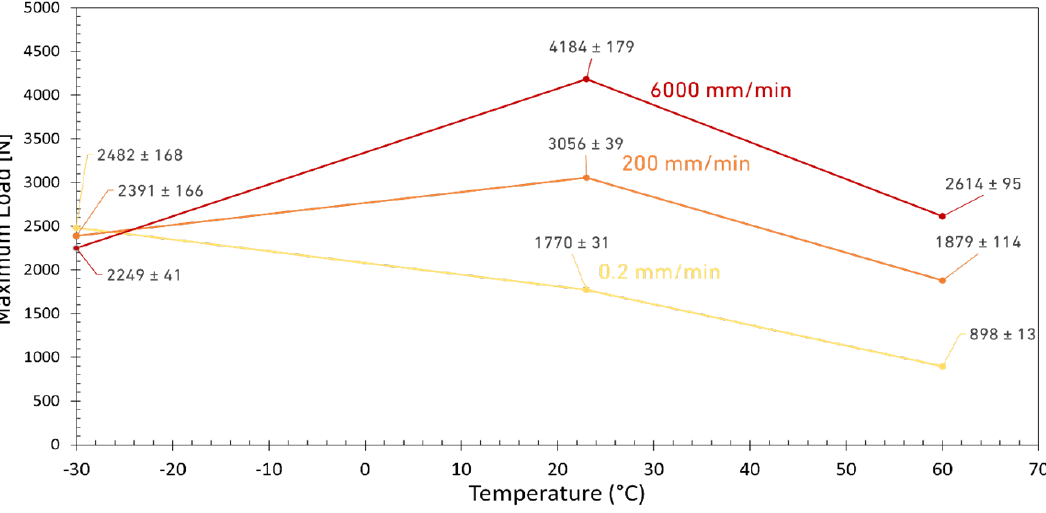
Figure 7. Maximum load as a function of temperature for three different loading rates.